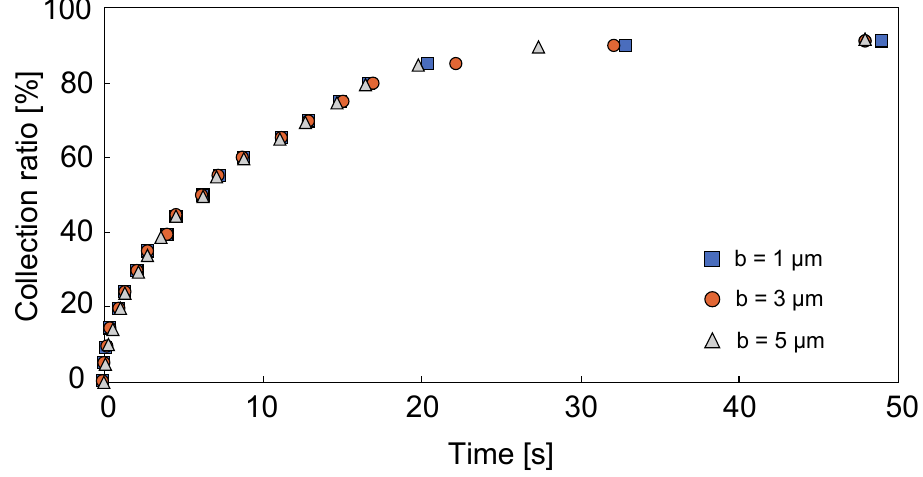
Figure 6. Time evolution of the bacterial capture rate by numerical simulation: the time trend of the capture rate remains essentially unchanged regardless of the electrode width.